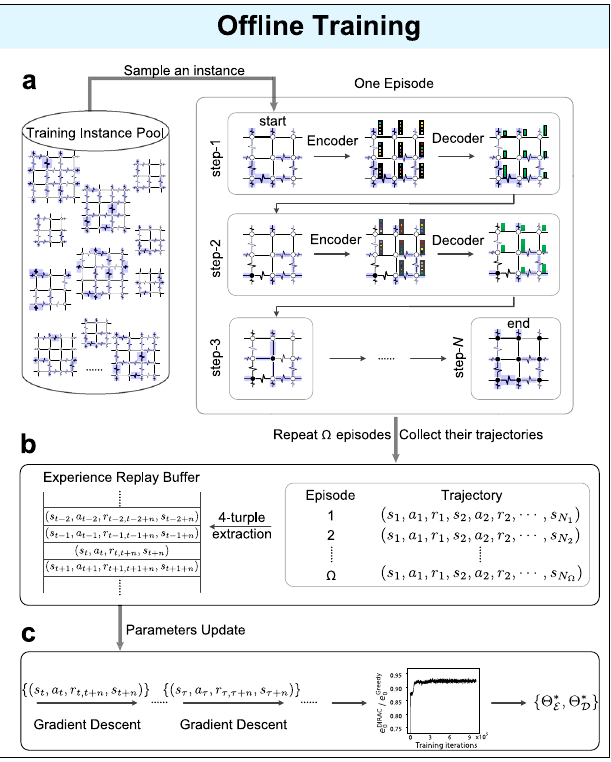
Fig. 2 | Overview of DIRAC. The DIRAC framework consists of two phases: of fl ine training and online application. ( Left ) During training, we fi rst generate random smallEAspinglassinstanceswithcouplingssampledfromGaussiandistribution,as thetrainingdata. a Foreachepisode,wesamplearandominstanceofsize N ,andlet DIRAClearnto fi nditsgroundstate.Duringeachepisode,theagentstartsfromthe all-spins-up con fi guration and ends at the all-spins-down con fi guration, with each spin fl ipped only once. For the next episode, we sample another training instance. To determine the right action to take, DIRAC fi rst adopts an encoder to represent each node as an embedding vector (shown as a color bar), and then decodes a Q - value (shown as a green bar with heights proportional to its value) for each node thatpredictsitslong-termgain. b Whenoneepisodeends,wecollectthetrajectory ( s 1 , a 1 , r 1 , … , s N ) generated during this process, extract the 4-tuple transitions, i.e., P t + n γ k r ( s t , a t , r t , t + n , s t + n ), where r t , t + n = k , and push them into the experience k = t replay buffer B , which is a queue that maintains S buffer most recent n